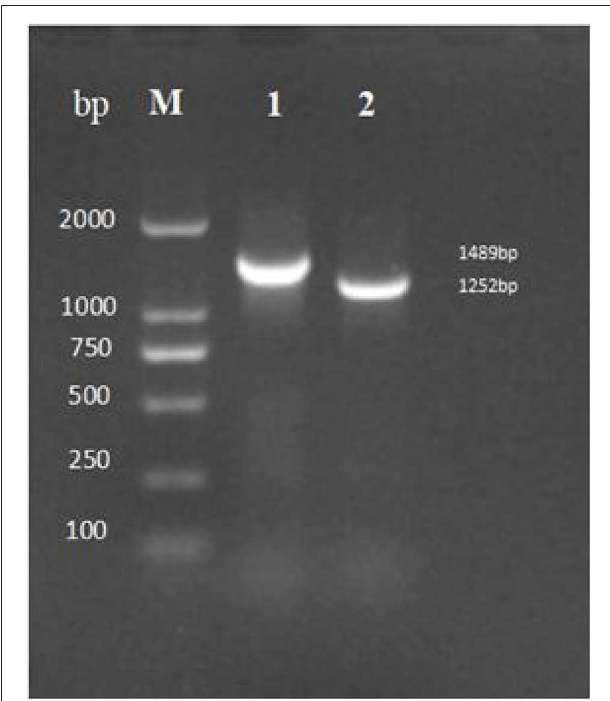
FIGURE 4 | Genetic stability detection of HY9901 1 tyeA deletion mutant. M: DL2000 marker, Lane 1. A fragment of 1,489 bp is obtained for HY9901 using primer pairs of tyeA-up/tyeA-down. Lane 2. A fragment of 1,252 bp is obtained for HY9901 1 tyeA using primer pairs of tyeA-up/tyeA-down.